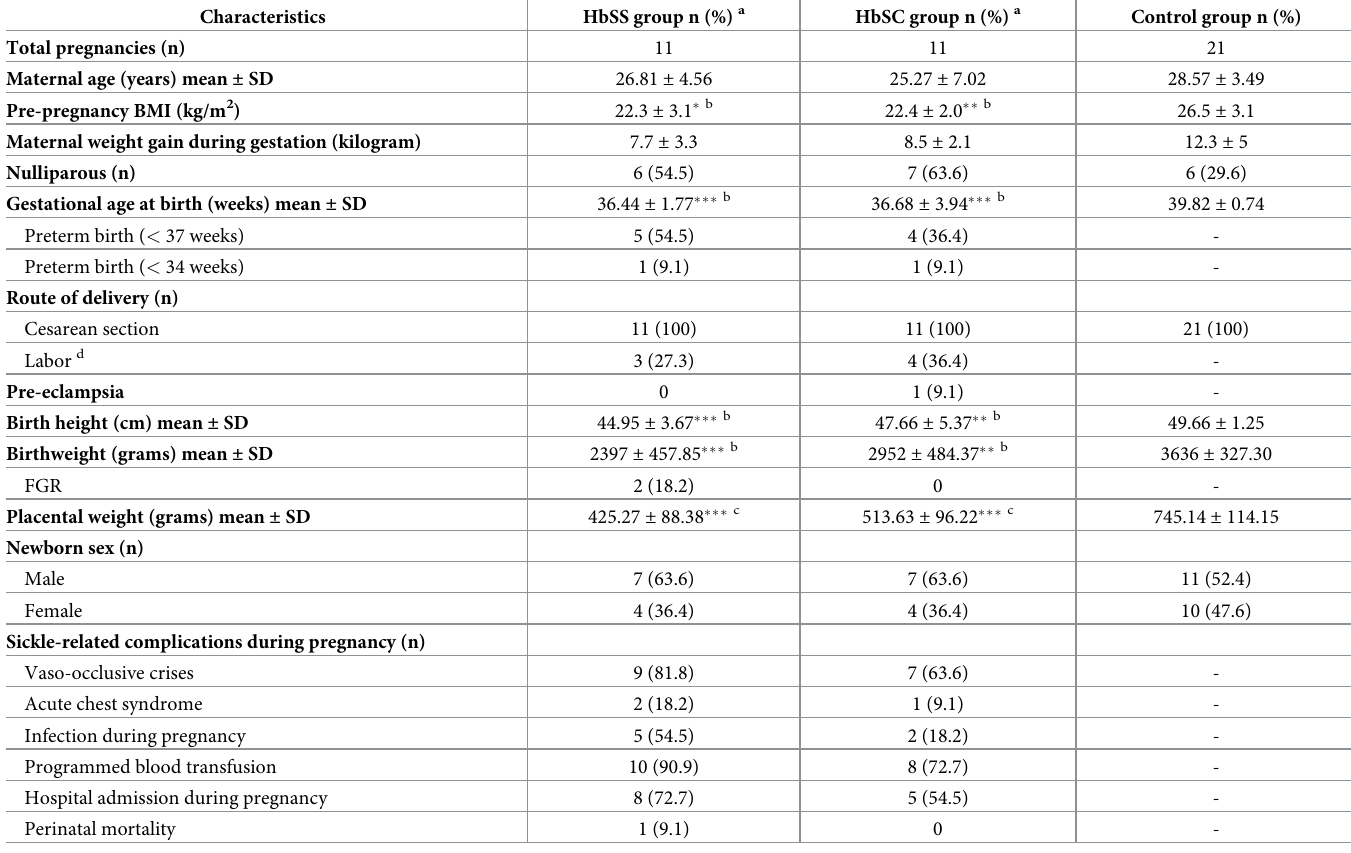
Table 3. Clinical characteristics, maternal and perinatal outcomes among cases (HbSS and HbSC) and controls.